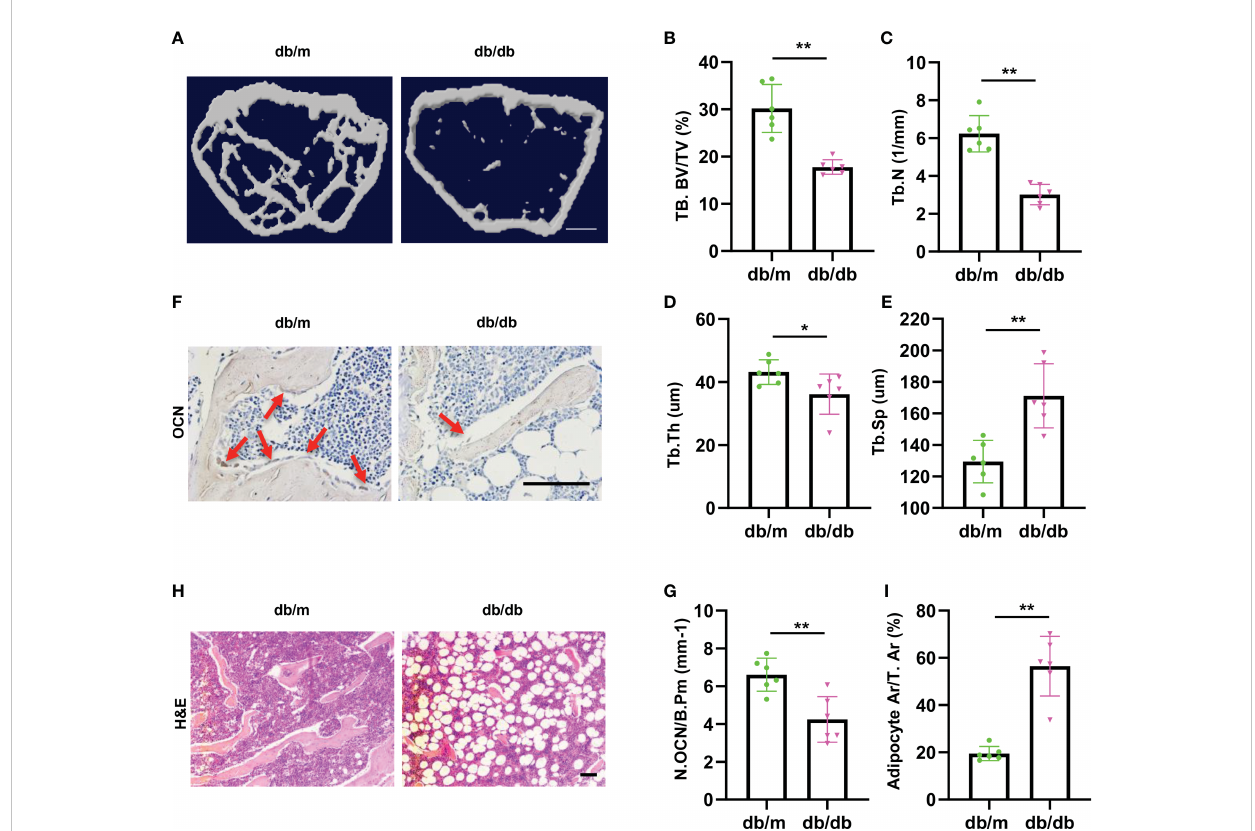
FIGURE 1 Diabetic mice show imbalanced bone formation and marrow fat accumulation. (A) Representative micro-computed tomography ( m CT) image of femurs from 3-month male diabetic (db/db) and normal (db/m) mice. (B-E) Quantitative m CT analysis of trabecular bone volume (B) , Trabecular bone number (C) , Trabecular thickness (D) and Trabecular separation (E) . Scale bar: 1 mm (F, G) Representative images of osteocalcin immunohistochemical staining (F) and number of osteoblasts in the distal femur (G) , red arrows represent osteocalcin-positive – staining cells. Scale bar: 100 m m. (H, I) Representative images of H&E staining (H) and area of adipose cells in the distal femur (I) . Scale bar: 100 m m. The data is shown as the mean ± SD. * P <0.05, ** P <0.01, Welch ’ s t test is used in (B) and (I) , Student ’ s t-test used for other fi gures, n=6 per